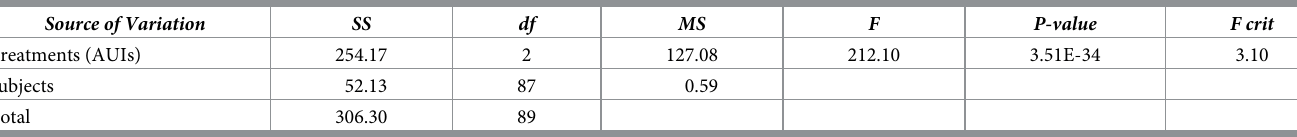
Table 12. One-way ANOVA—Viewpoint #2.